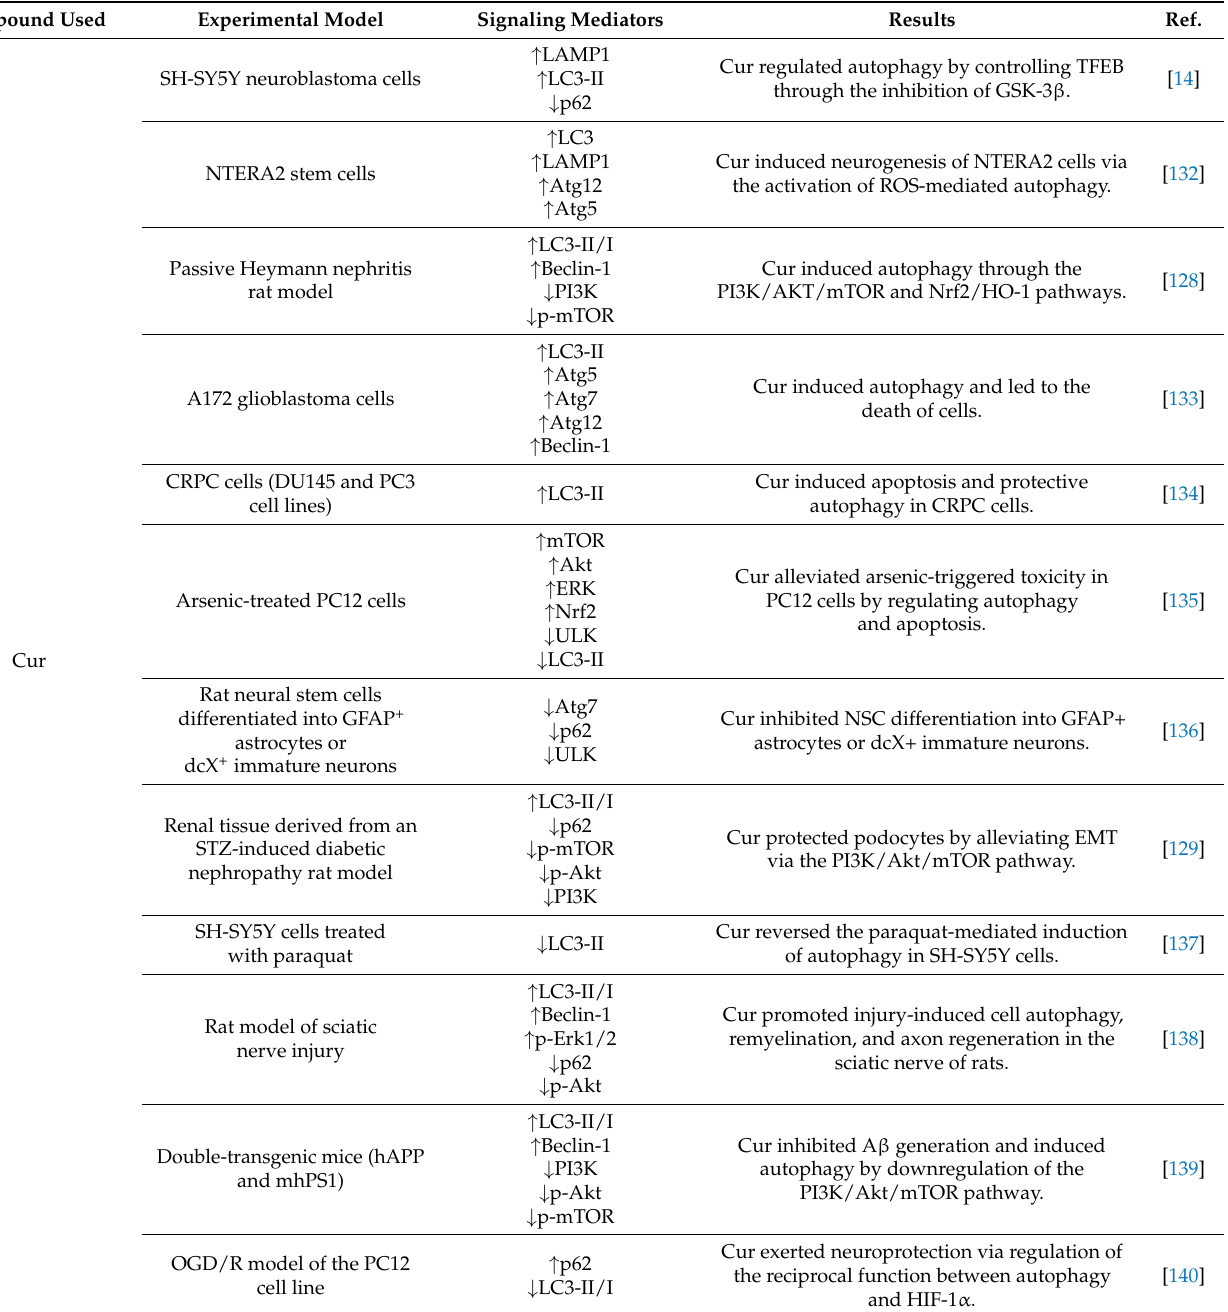
Table 6. Summary of selected available data on the modulation of autophagy by curcumin and its